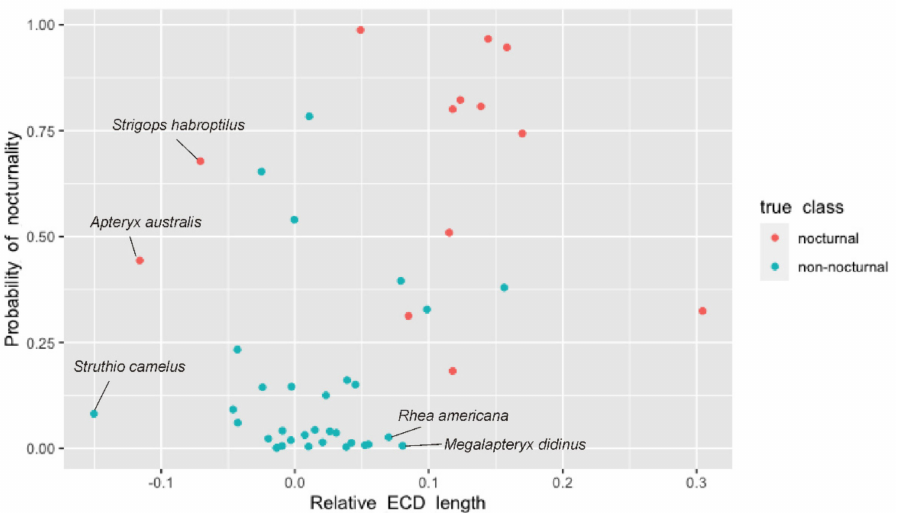
Figure 13. Plot of endosseous cochlear duct residuals against probability of nocturnality from eye measurements.